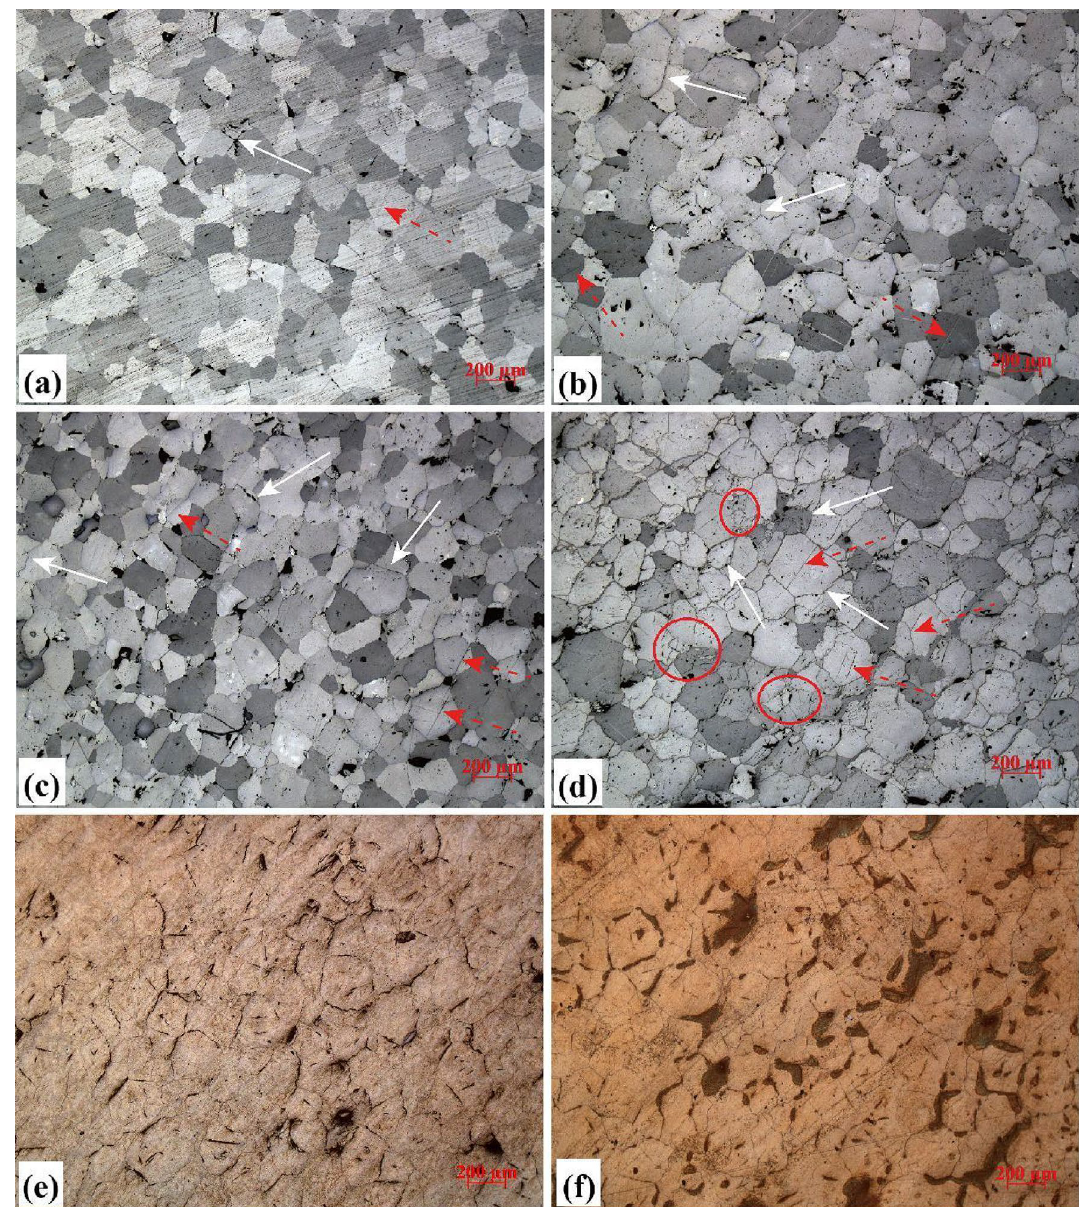
Figure 2. Photomicrographs of marble samples exposed to different temperatures in plane-polarized light: ( a ) M25; ( b ) M200; ( c ) M400; ( d ) M600; ( e ) M800; and ( f ) M1000. From photo ( a – d ), the inter-granular micro- cracks (indicated by white solid arrows) and intra-granular micro-cracks (indicated by red dotted arrows) are developed more extensively as the increase of treatment temperature. Crush zones (indicated by red circles) are observed in photo ( d